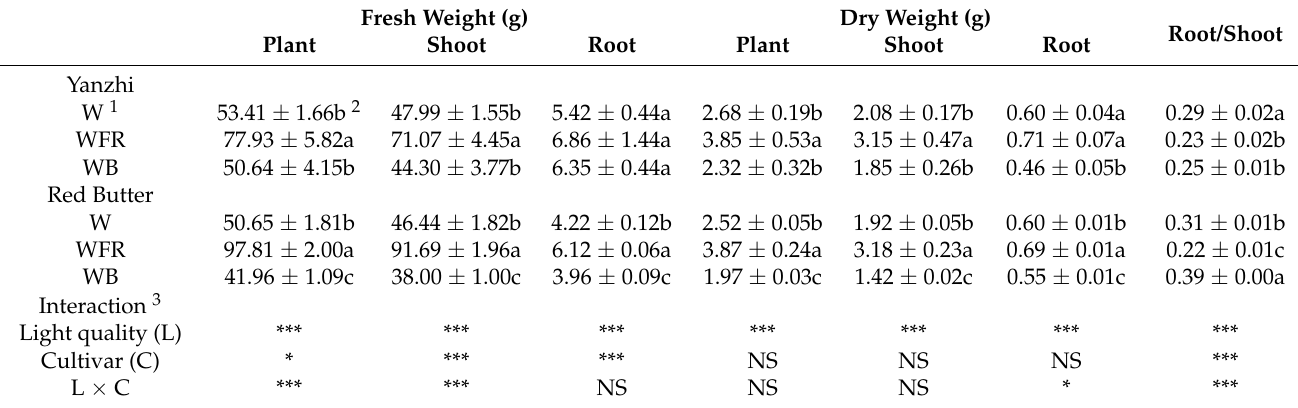
Figure 1. The morphology of two cultivars of red-leaf lettuce under different light quality. The lettuce ( a ) “Yanzhi” and ( b ) “Red Butter”. W = equalized-white light; WFR = W plus far-red light; WB = W plus blue light. Table 2. Effects of different light quality on plant biomass of